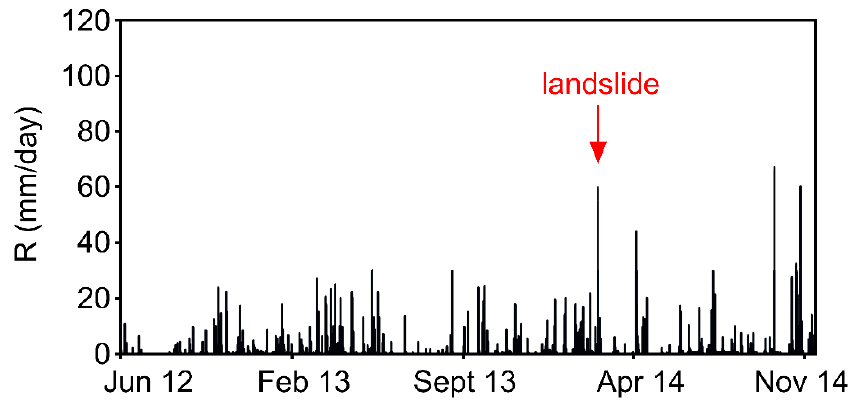
Figure 6. Daily rainfall recorded from June 2012 to November 2014 at the considered site (modified from [45]).